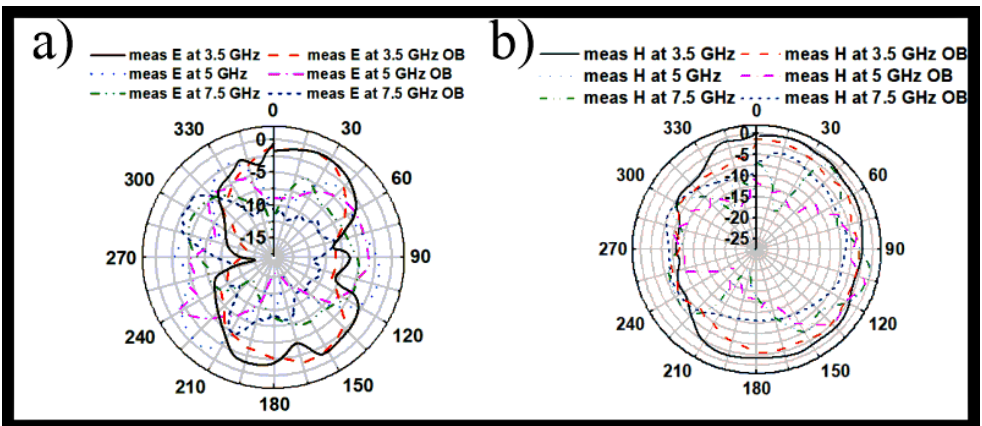
Figure 7. Radiation patterns: ( a ) E-plane; ( b ) H-plane.